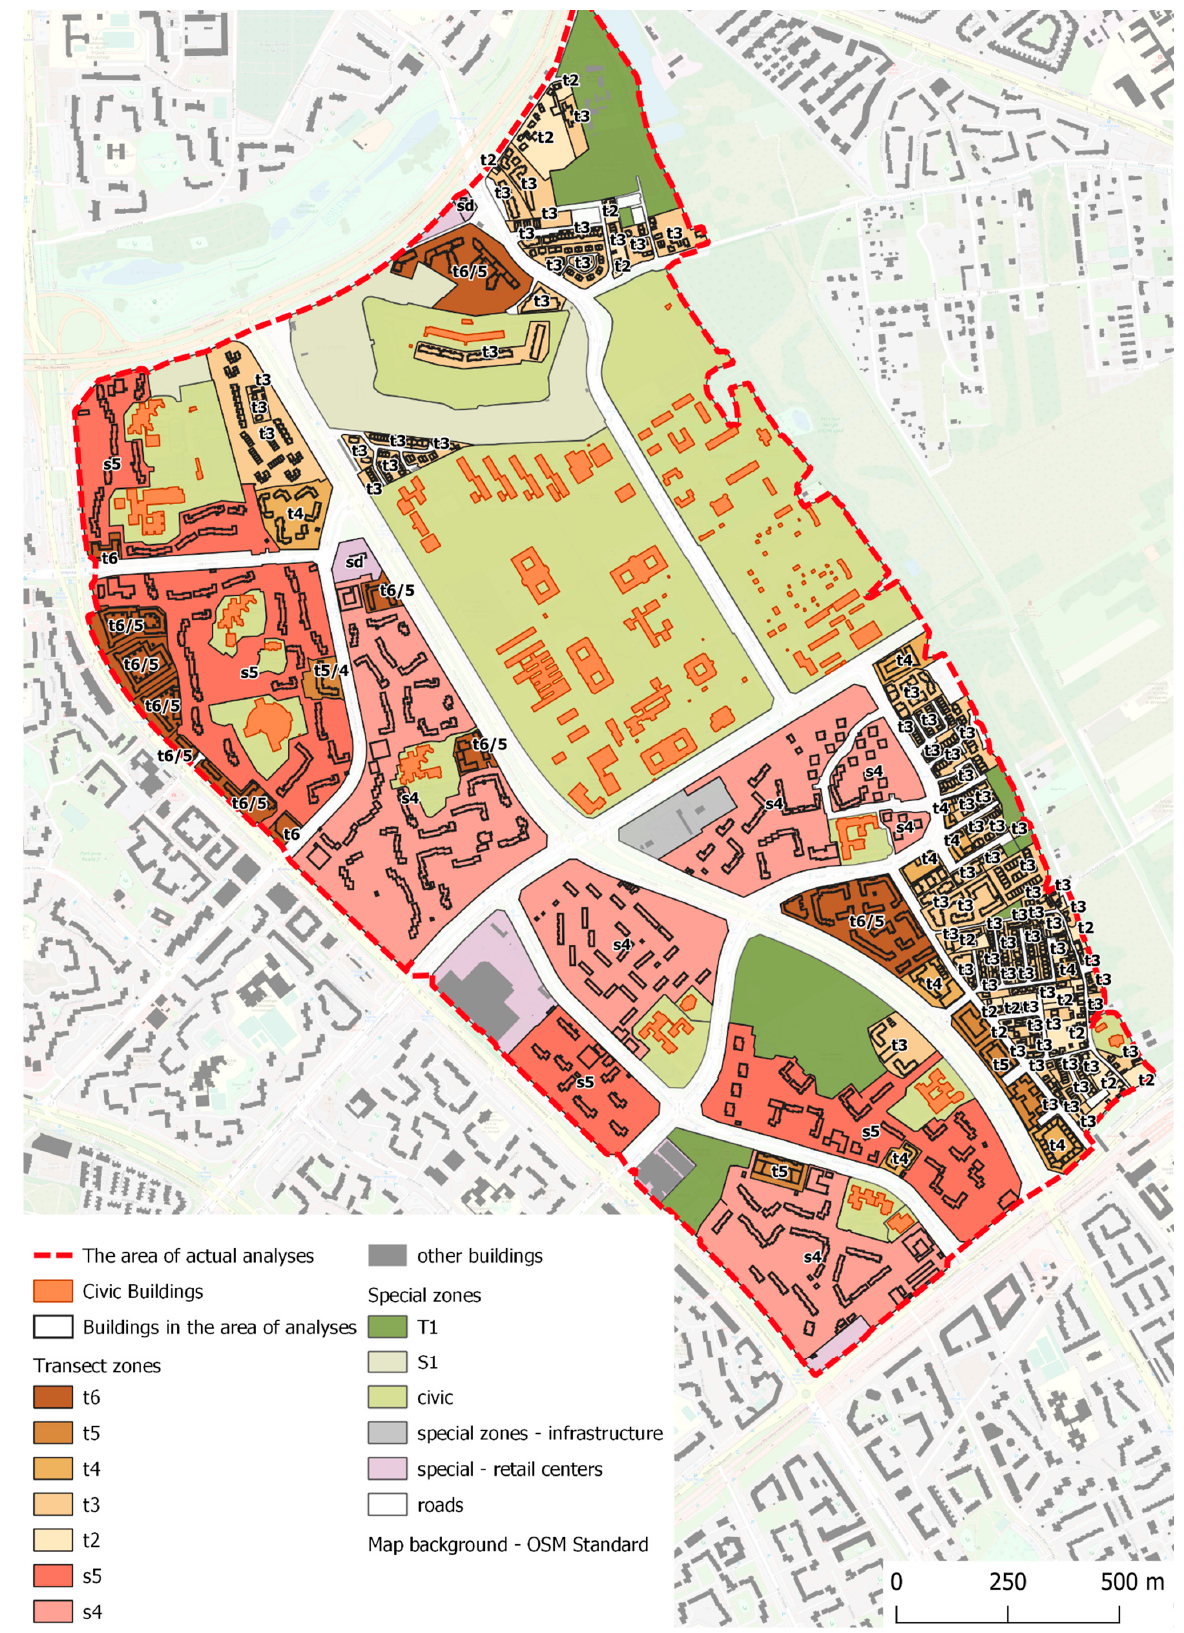
Figure A6. The urban structure of the analysed area in transect